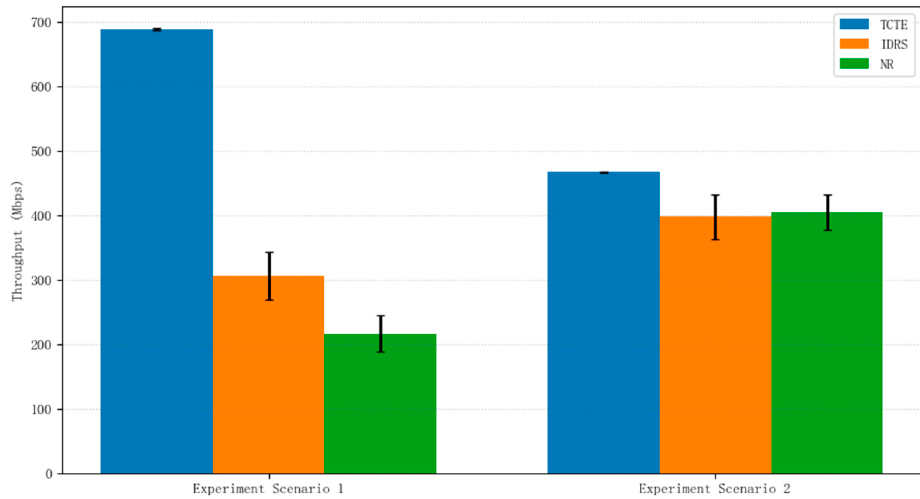
Figure 9. Mean and con fi dence intervals for edge node throughput.